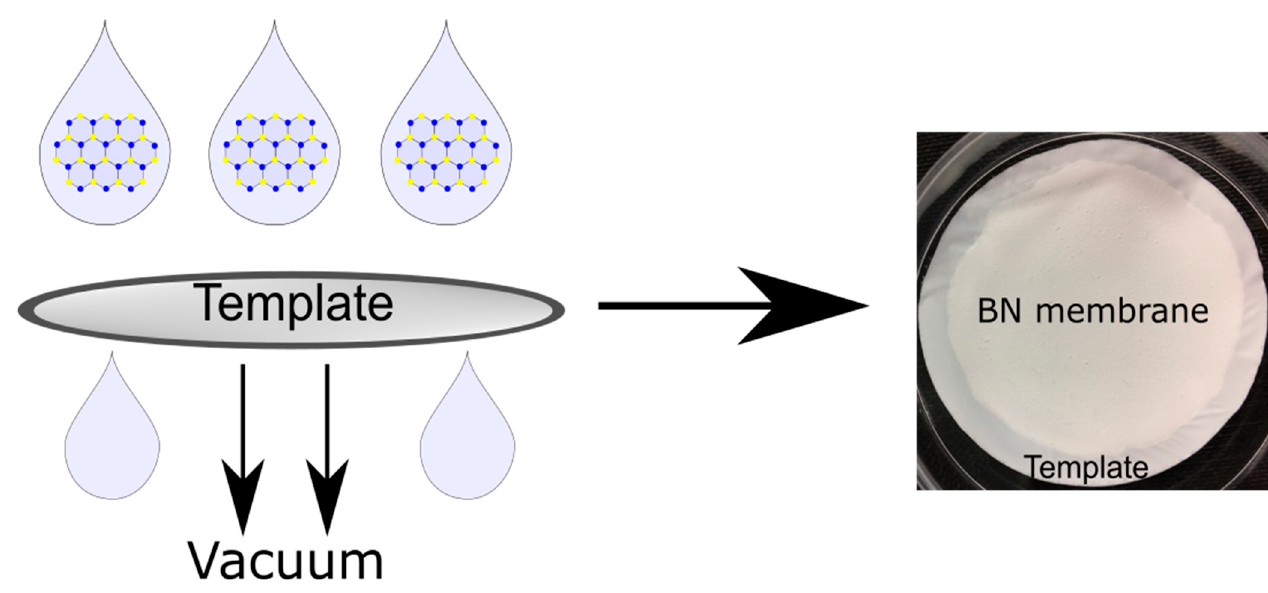
Figure 6. Schematic representation of BN membrane formation using vacuum filtration. SEM images of each resulting membrane were taken and are presented in Figure 7.